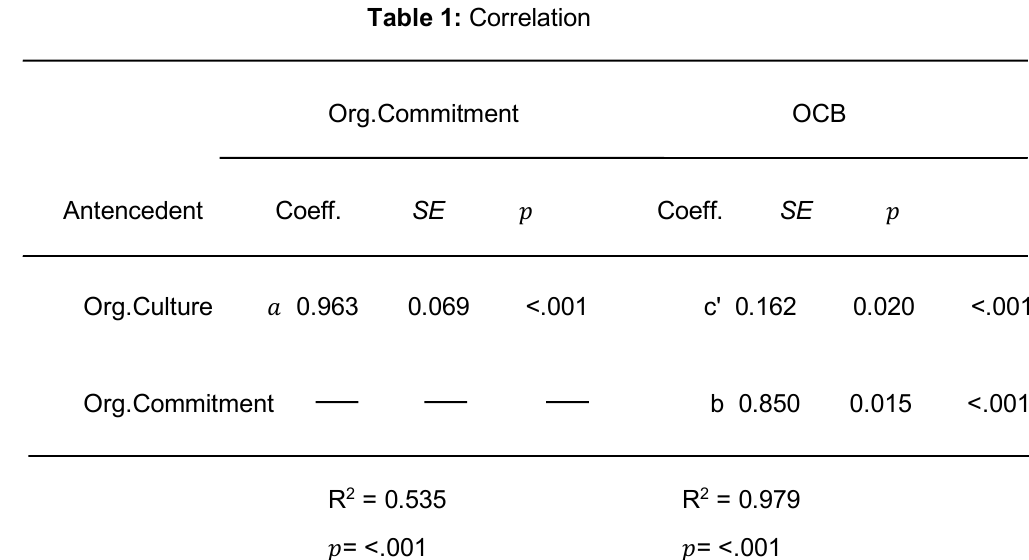
Figure 1: Simple Mediation